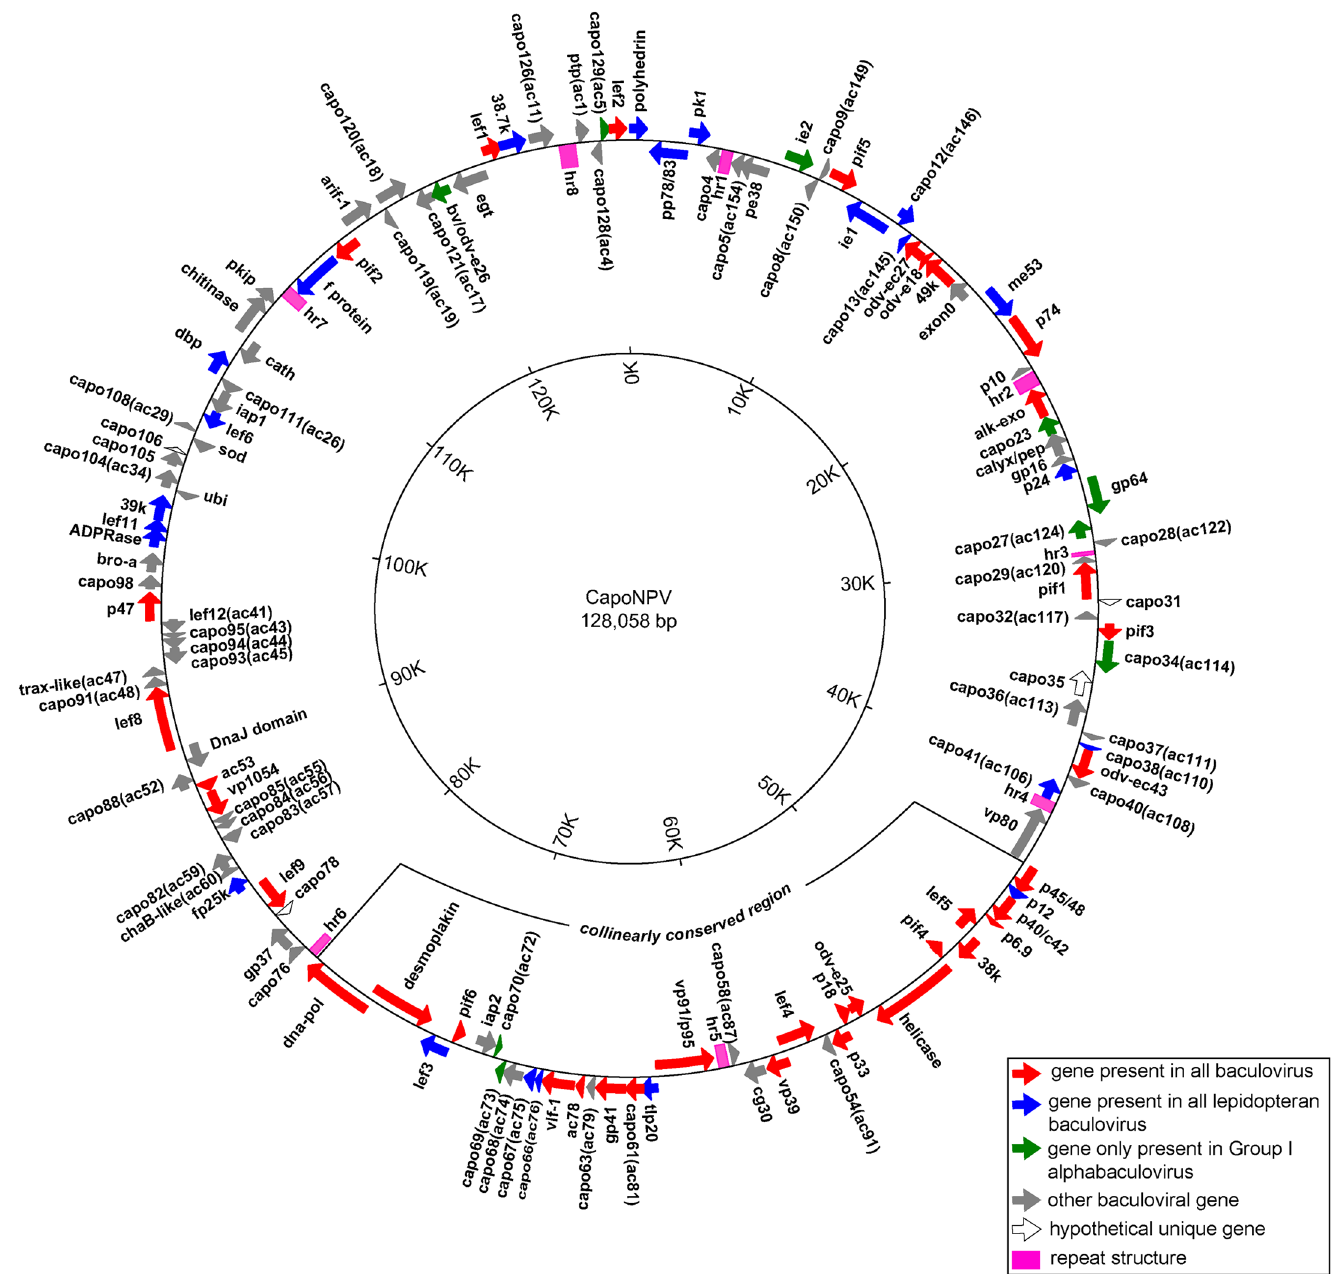
Fig 1. The circular map of CapoNPV. ORFs and direction of transcription are indicated by arrows. The colors represent gene types: red for core genes, blue for lepidopteran conserved genes, green for Group I specific genes, grey for other baculoviral genes. Open arrows represent hypothetical unique genes of CapoNPV. Hr s are represented by pink square boxes. The collinear region conserved in lepidopteran baculoviruses is also